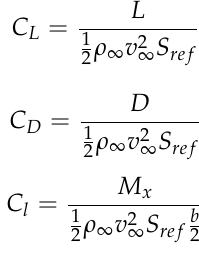
Figure 2. Positions of different control surfaces.